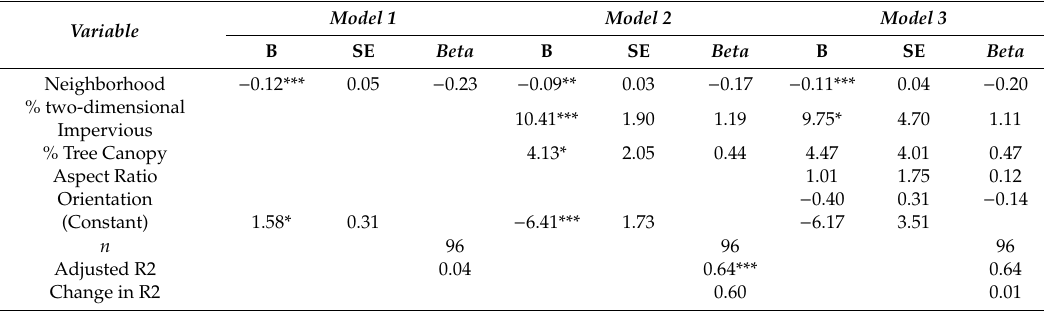
Table 7. Regression analysis for UHI temperatures at 2 a.m. using two-dimensional approach in eight Chicago neighborhoods in summer 2010.